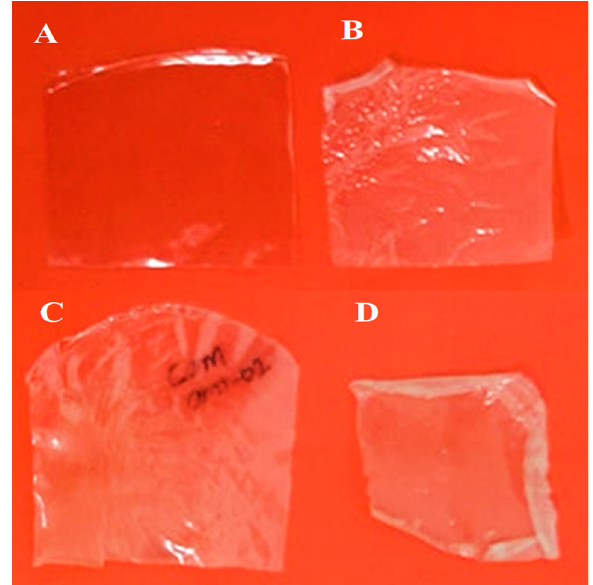
Figure 3. Optical images for ( A ) SPEES, ( B ) SPEES-AM-01, ( C ) SPEES-AM-02, and ( D ) SPEES-AM-03.